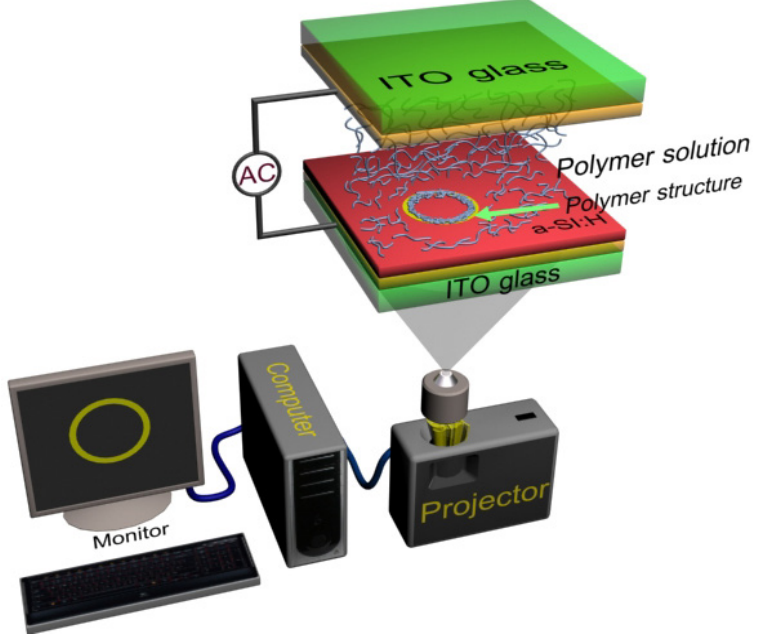
Figure 1. Schematic illustration of the “ODEP System”. When a patterned light beam is focused through a microscope condenser lens and projected onto the a-Si:H layer on the “ODEP Chip”, a non-uniform electric field is generated when an a.c. bias voltage is applied across the “ODEP chip”. Hydrogel molecules in solution are then polarized and attracted to the region around the patterned light